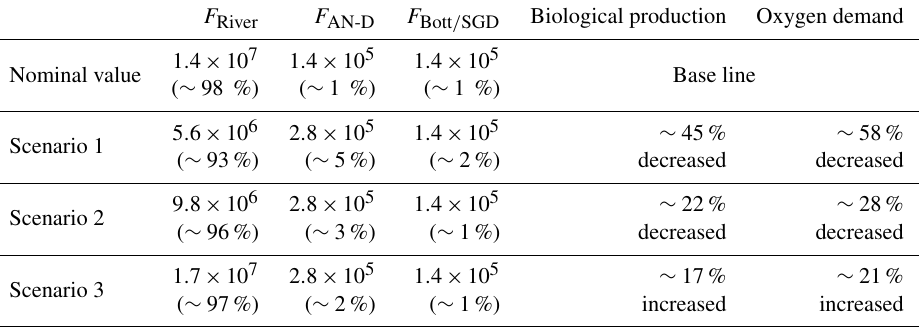
Table 4. Simulation results for selected model scenarios based on MCH M1 (5–7 April 2004), as described in the text. Biological production is calculated using our N mass balance model, while oxygen demand is calculated by the Redfield stoichiometry ratio (C: − O 2 = 106 : 138; unit: gCm − 2 d − 1